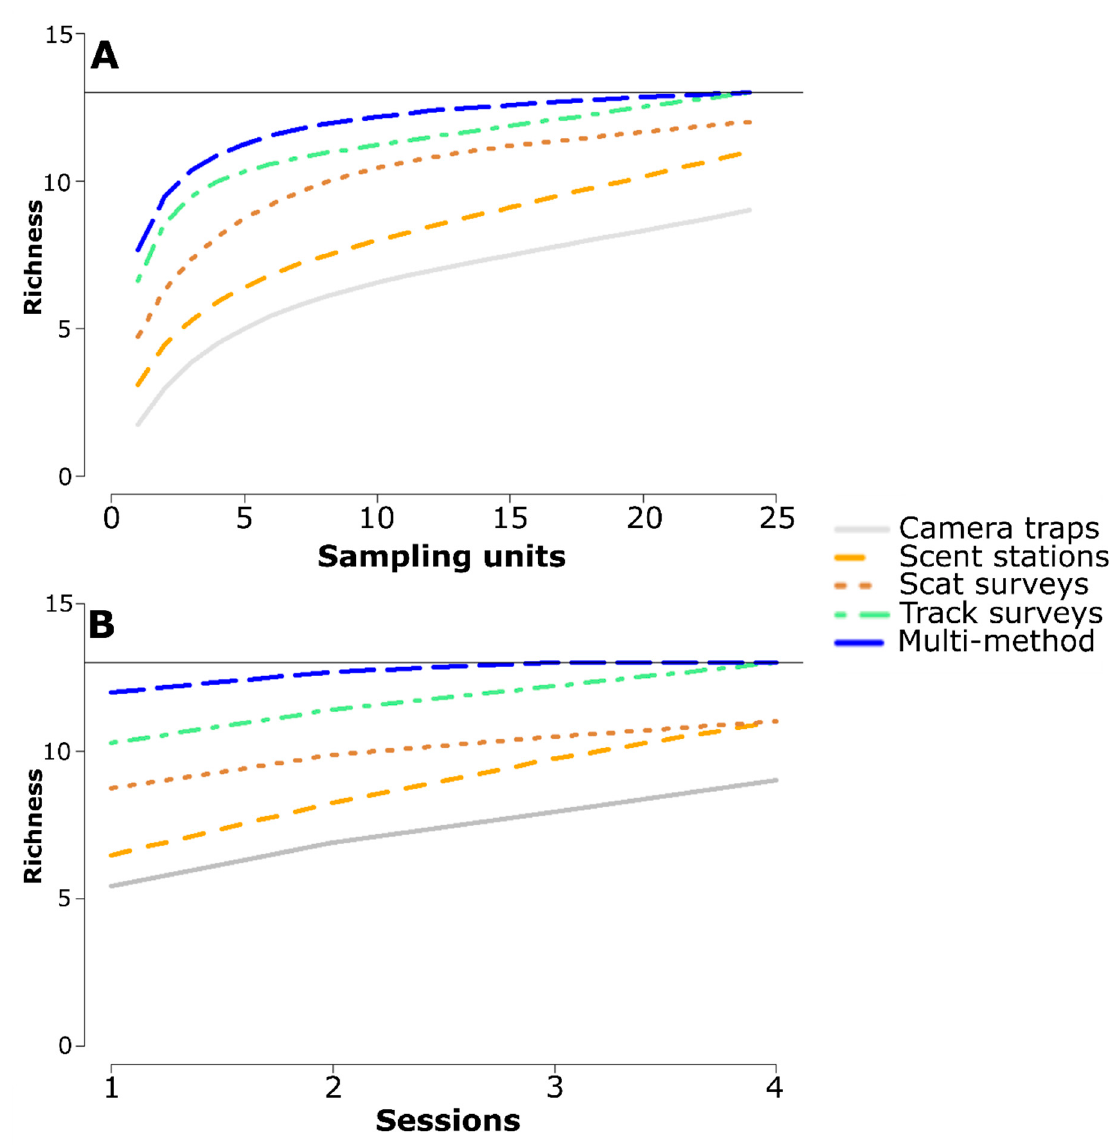
Figure 3. Estimated accumulation curves of species richness built with data from different survey methods as a function of effort in terms of ( A ) spatial replicates surveyed across the study area, and ( B ) temporal replicates six months apart. The horizontal line indicates the actual richness of the regional species pool.